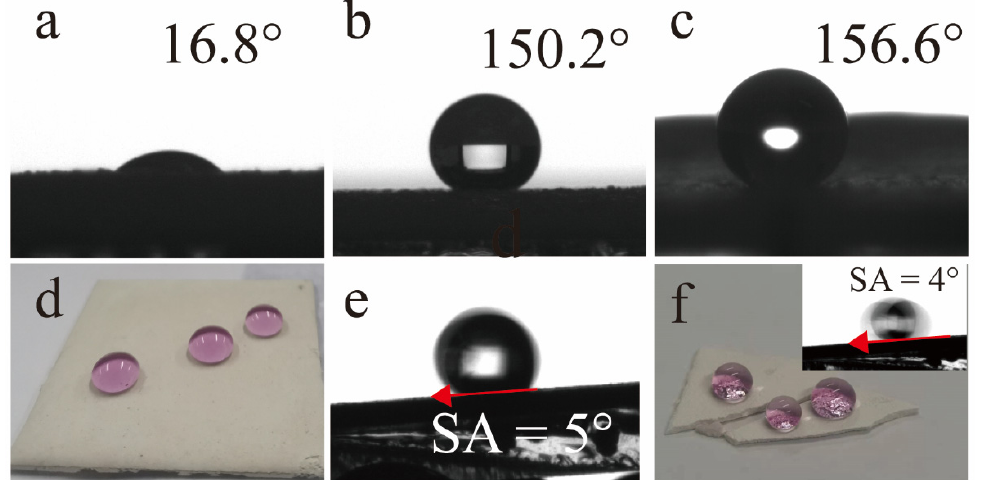
Figure 2. Coating contact angle: ( a ) surface of GP, ( b ) surface of GP-SHC, ( c ) bottom of GP-SHC; ( d ) water droplet contact diagram of GP-SHC’s surface, ( e ) roll angle of GP-SHC’s surface; ( f ) water droplet contact diagram of GP-SHC’s bottom.